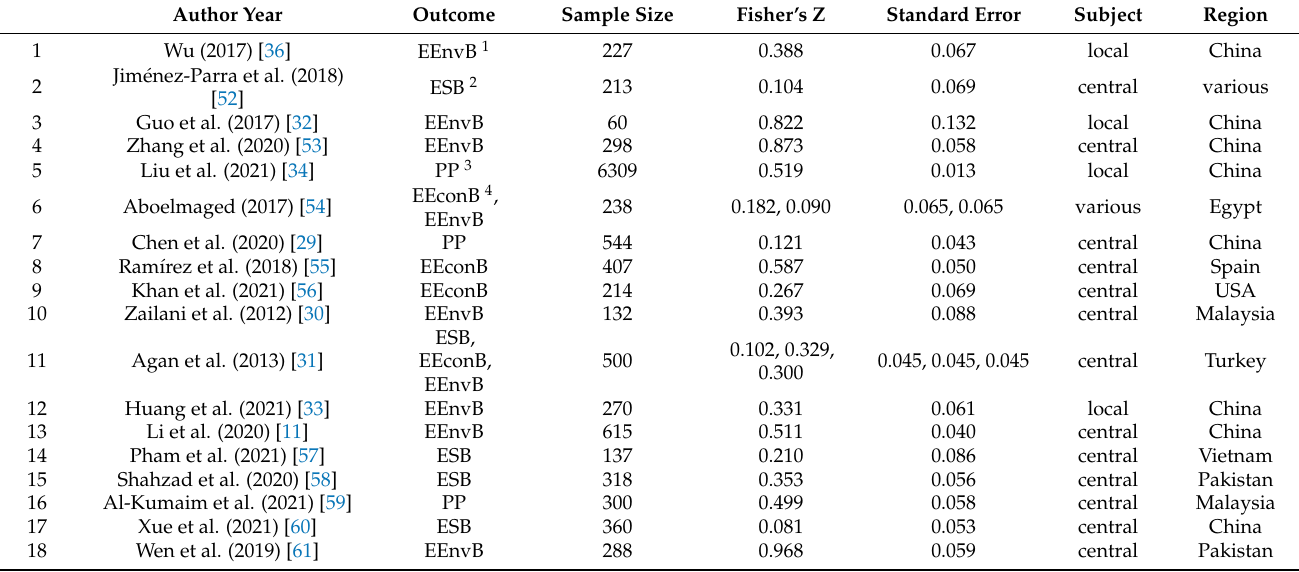
Table 2. Target literature code table.